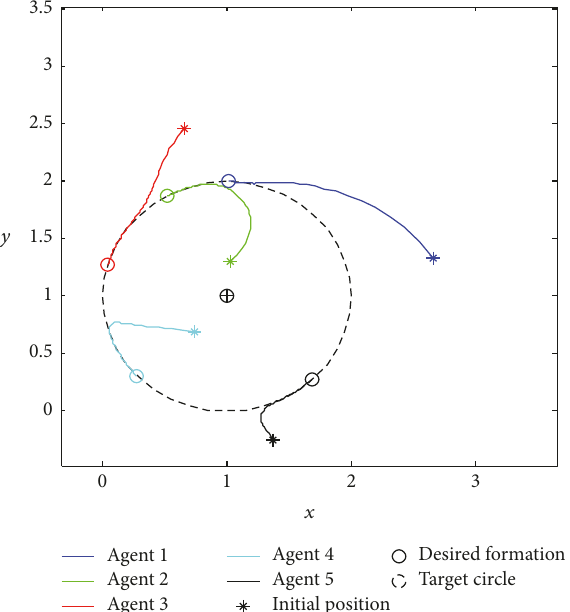
Figure 7: Circular formation trajectories 𝑝 𝑘 (𝑡) with 𝜑 𝑑 = 𝜋/2